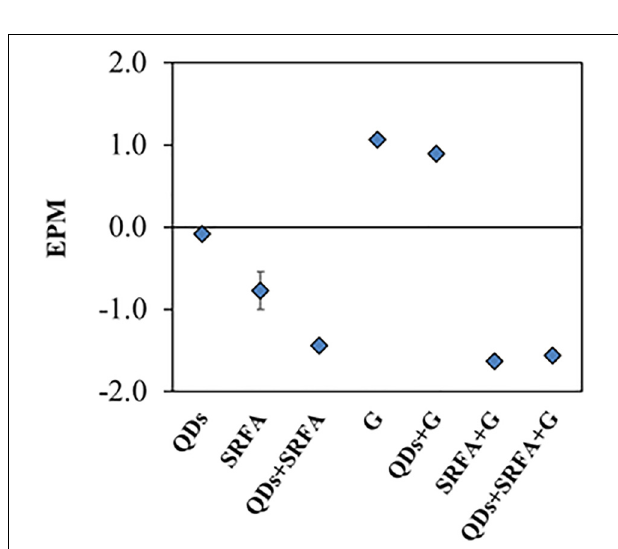
FIGURE 3 | EPM data obtained for the different samples containing only QDs, FA and goethite, and mixtures of them after 24 h of